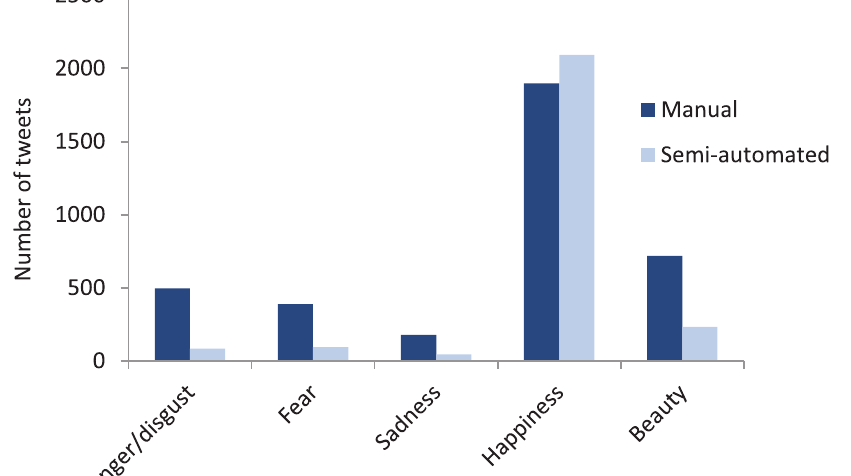
Figure 5. The number of tweets assigned by the manual and semi-automated methods into discrete emotion categories. Percentage agreement between the two